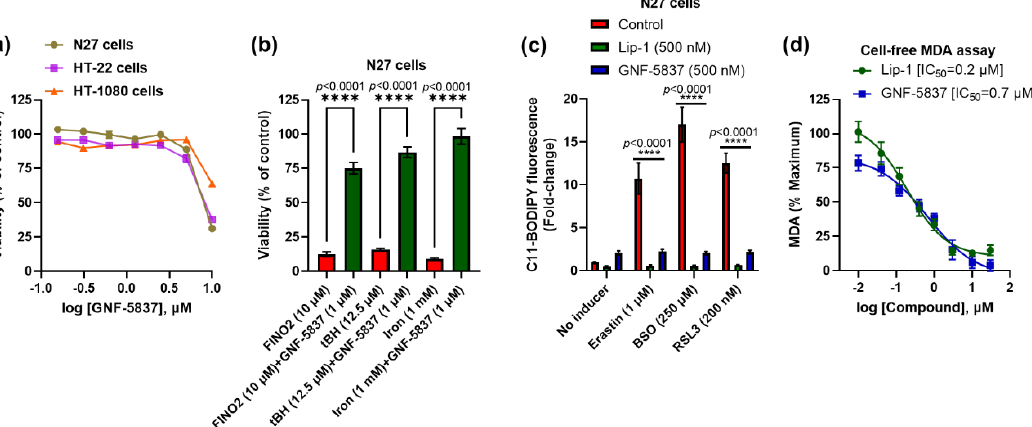
Figure 5. GNF-5837 protects against ferroptosis likely via its RTA property. Toxicity assay upon 48 h treatment with GNF-5837 in different cell lines ( a ). GNF-5837 protects against toxicity induced by FINO2, tBH, and iron in N27 cells ( b ). Like Lip-1, GNF-5837 significantly protects against lipid peroxidation in the C11 BODIPY assay caused by erastin, BSO, and RSL3 in N27 cells ( c ). RTA property of GNF-5837 and Lip-1 against lipid peroxidation in cell-free MDA assay ( d ). Cells were co-treated with ferroptosis inducers and tested compounds for 24 h, except for tBH-induced ferroptosis, which had a 4 h co-treatment, and MTT assay measured cell viability. Lipid peroxidation in C11 BODIPY assay is expressed as the ratio of green to red C11 BODIPY fluorescence. Data points signify mean percentage survival relative to respective controls ± SEM ( n = 36 for ( a ), n = 9– 12 for ( b , c ), and n = 6 for ( d ) from 3 – 4 independent experiments). P values were calculated using the one-way ANOVA (Tukey ’ s multiple comparisons test for ( b )) and two-way ANOVA (Dunnett ’ s multiple comparisons test for ( c )), and the significant level is noted as **** p < 0.0001 (vs. inducers/control). 3. Discussion Growing evidence of altered BDNF-TrkB signalling in neurodegeneration has spurred interest in understanding the possible underlying mechanisms. Ferroptosis is also implicated in neurodegeneration, and TrkB trophic signalling conceivably interferes with this pathway. Here, we reveal that several modulators of TrkB inhibit ferroptosis via a receptor-independent RTA mechanism. While BDNF is a potent agonist of the TrkB receptor, systemic therapy with BDNF has several pharmacokinetic limitations, such as short half-life, large molecular size, and poor blood – brain barrier (BBB) penetration. As an orally bioactive flavonoid, 7,8-DHF penetrates the BBB to act as an agonist of the TrkB receptor, and numerous preclinical studies [29,30] demonstrate that this compound exhibits BDNF mimetic activity. The 7,8- DHF flavonoid ameliorated memory impairment and neuronal cell death in several stud- ies of AD mouse models [29,30,33]. While 7,8-DHF has been reported as a TrkB agonist, it was unclear whether neuroprotection depends on the activation of the TrkB signalling pathway. We found that 7,8-DHF possesses potent anti-ferroptotic activity in cell lines that do not express detectable TrkB receptors, suggesting its anti-ferroptotic activity was due to another mechanism, such as the RTA activity that we showed in a cell-free assay. Therefore, it is possible that neuroprotection by 7,8-DHF was due to its RTA property in those prior studies rather than to TrkB signalling.